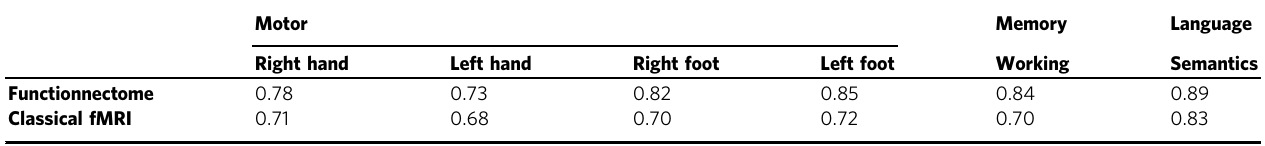
Table 1 Reproducibility of the results for each task for the Functionnectome and classical fMRI